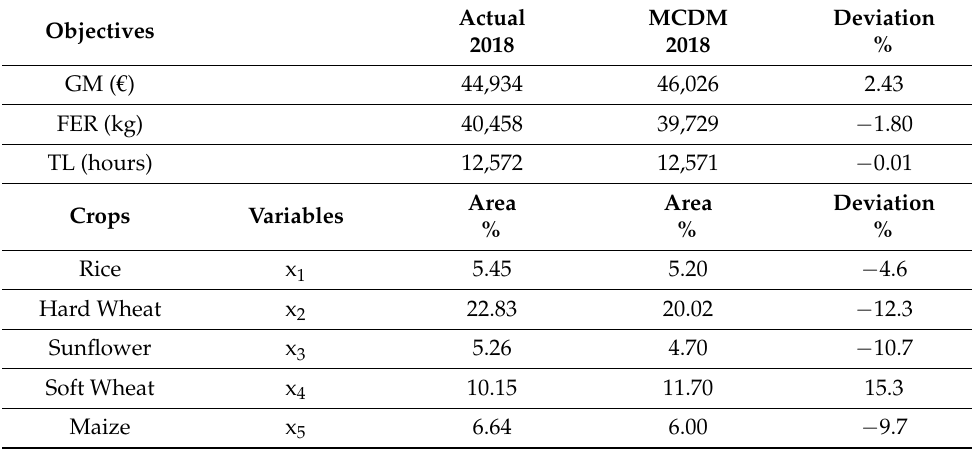
Table 4. Optimum crop plan and MCDM model values for the year